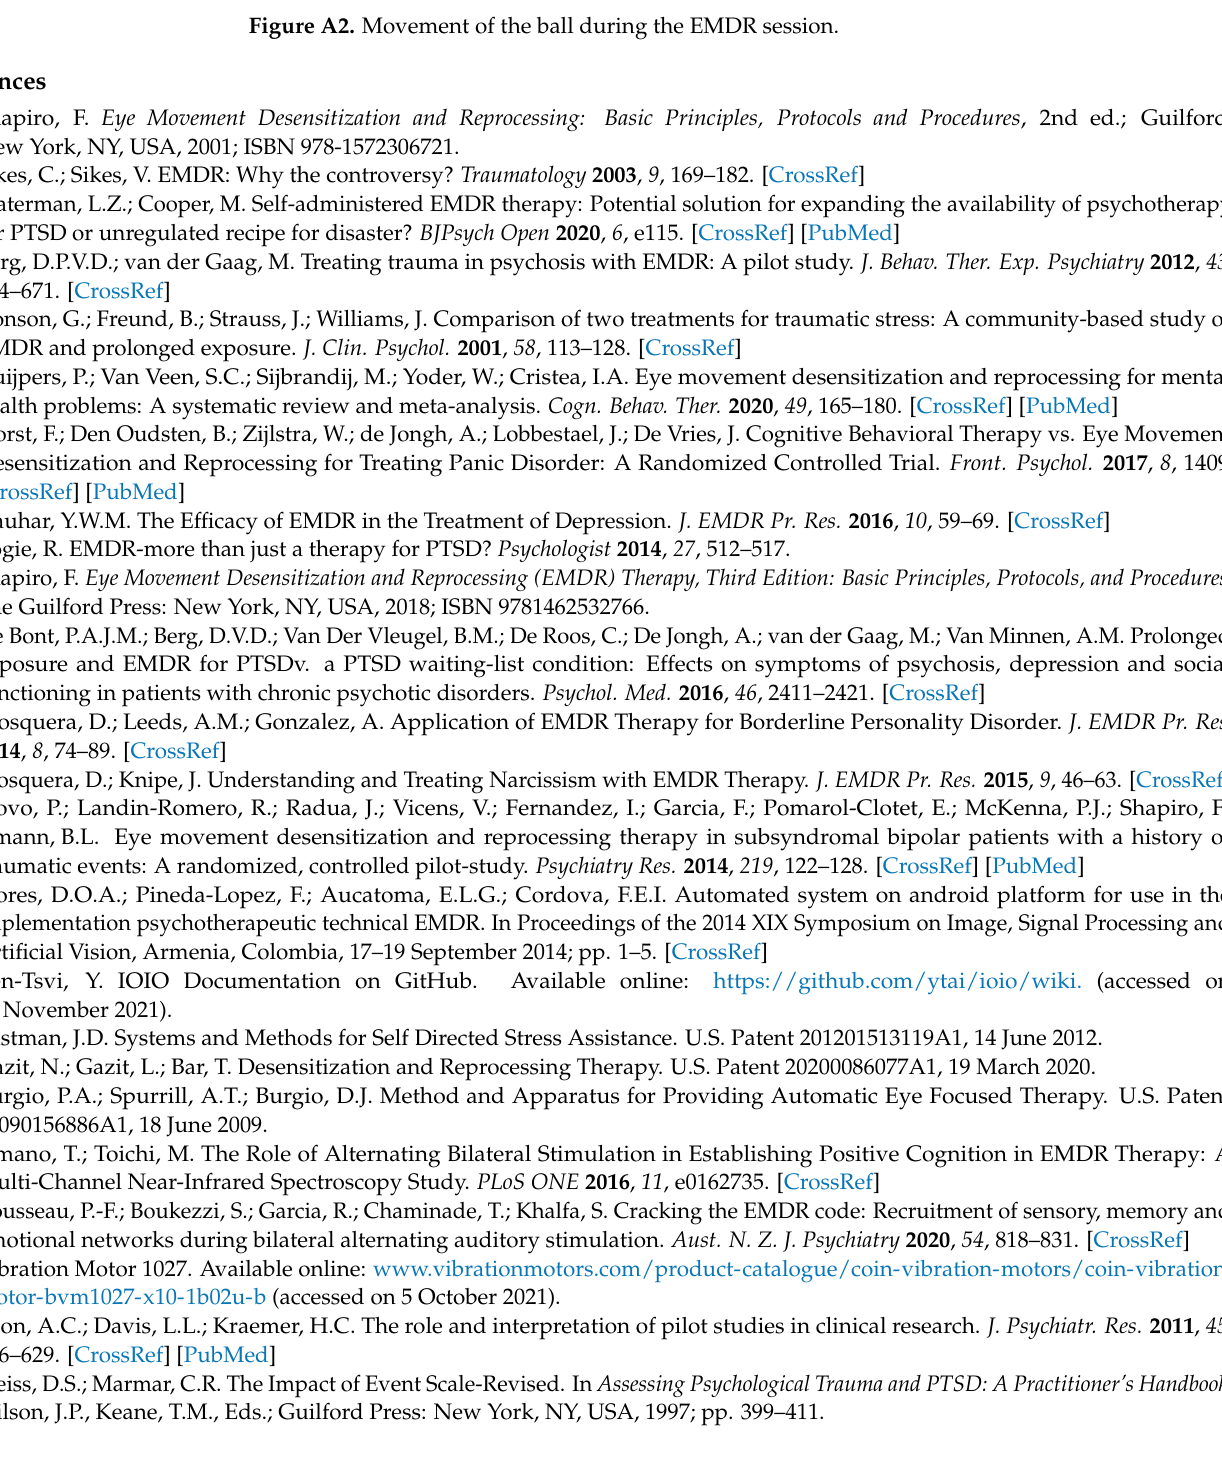
Figure A2. Movement of the ball during the EMDR session.